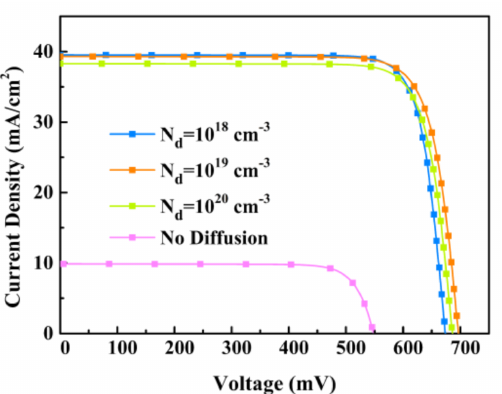
Figure 6. Simulated current-density voltage (J-V) curves of solar cells under light for di ff erent FSF doping concentrations.